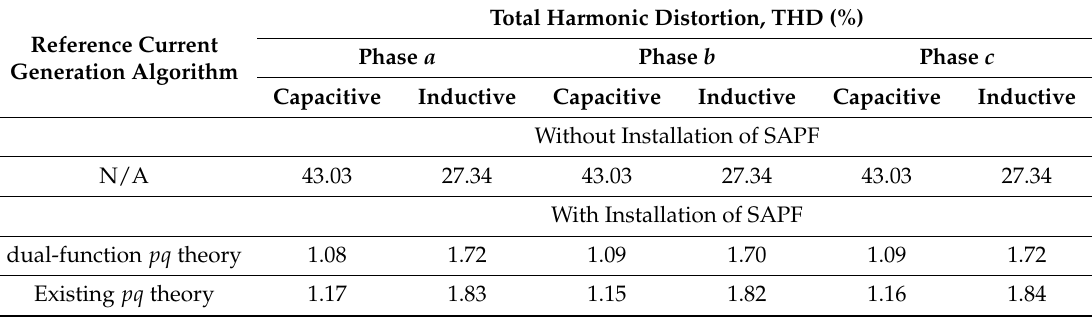
Table 1. Simulation result showing THD values of source current demonstrated by SAPF while applying its respective reference current generation algorithm, for capacitive and inductive